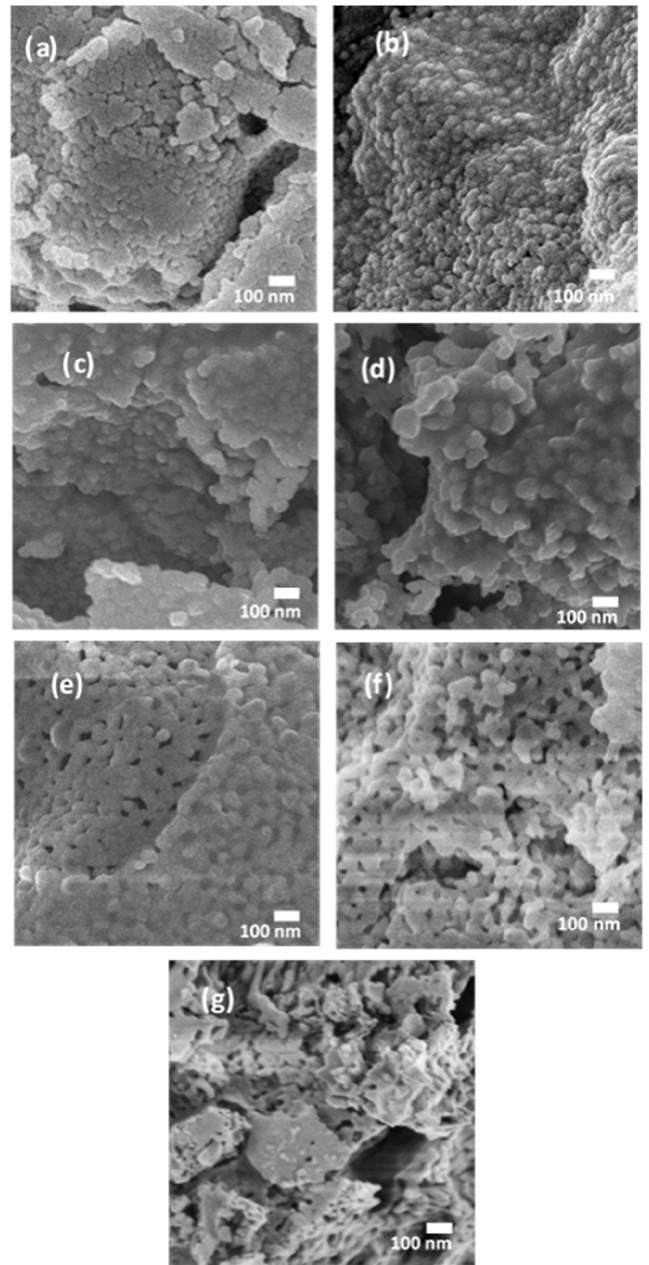
Figure 2. ( a ) LaCrO 3 , ( b ) LaNiO 3 , ( c ) LaCoO 3 , ( d ) LaMnO 3 , ( e ) LaFeO 3 , ( f ) SmFeO 3 and ( g ) GdFeO 3 .